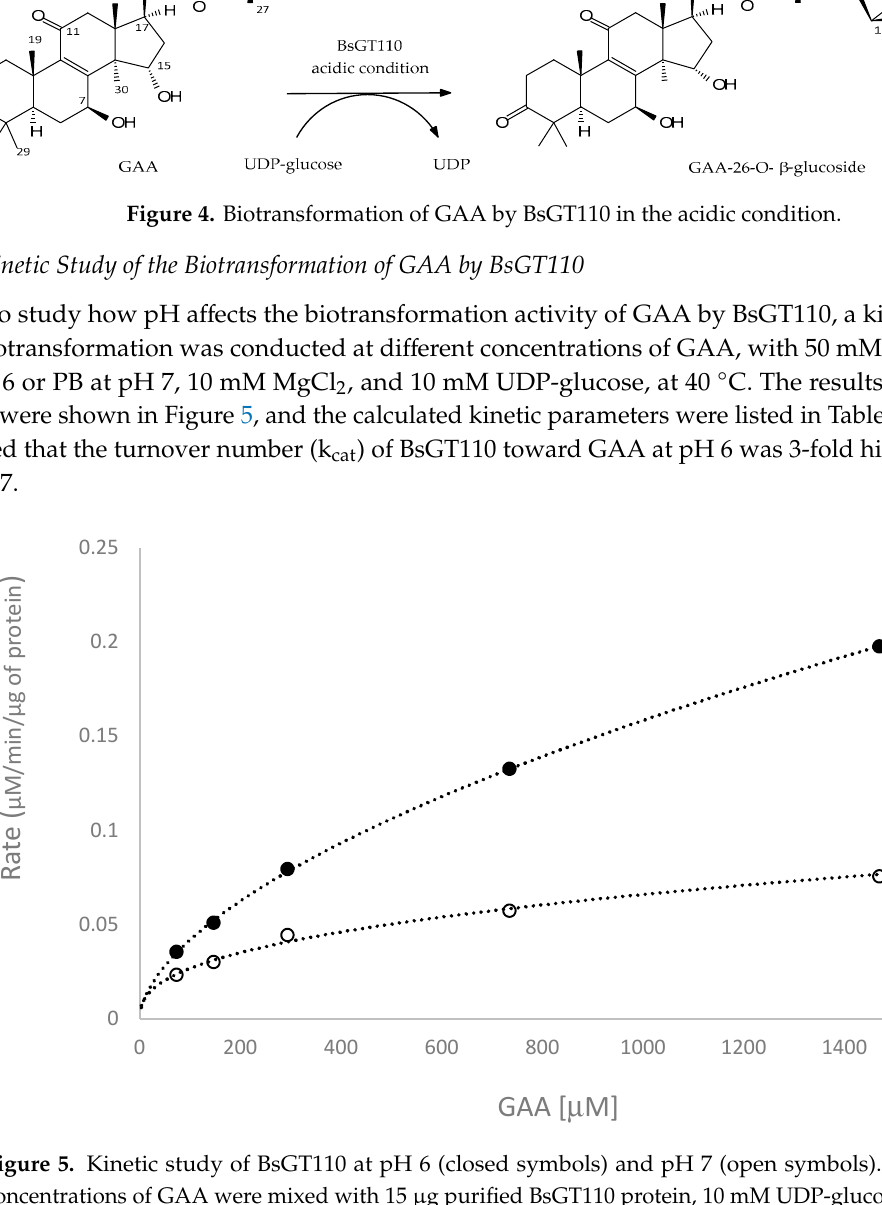
Table 2. Kinetic parameters of BsGT110 toward GAA at pH 6 and pH 7.